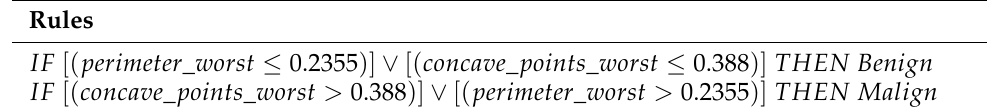
Table A9. Final rule set, for the BCWD dataset generated by